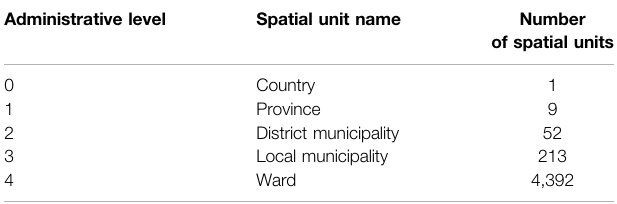
TABLE 1 | South Africa ’ s administrative